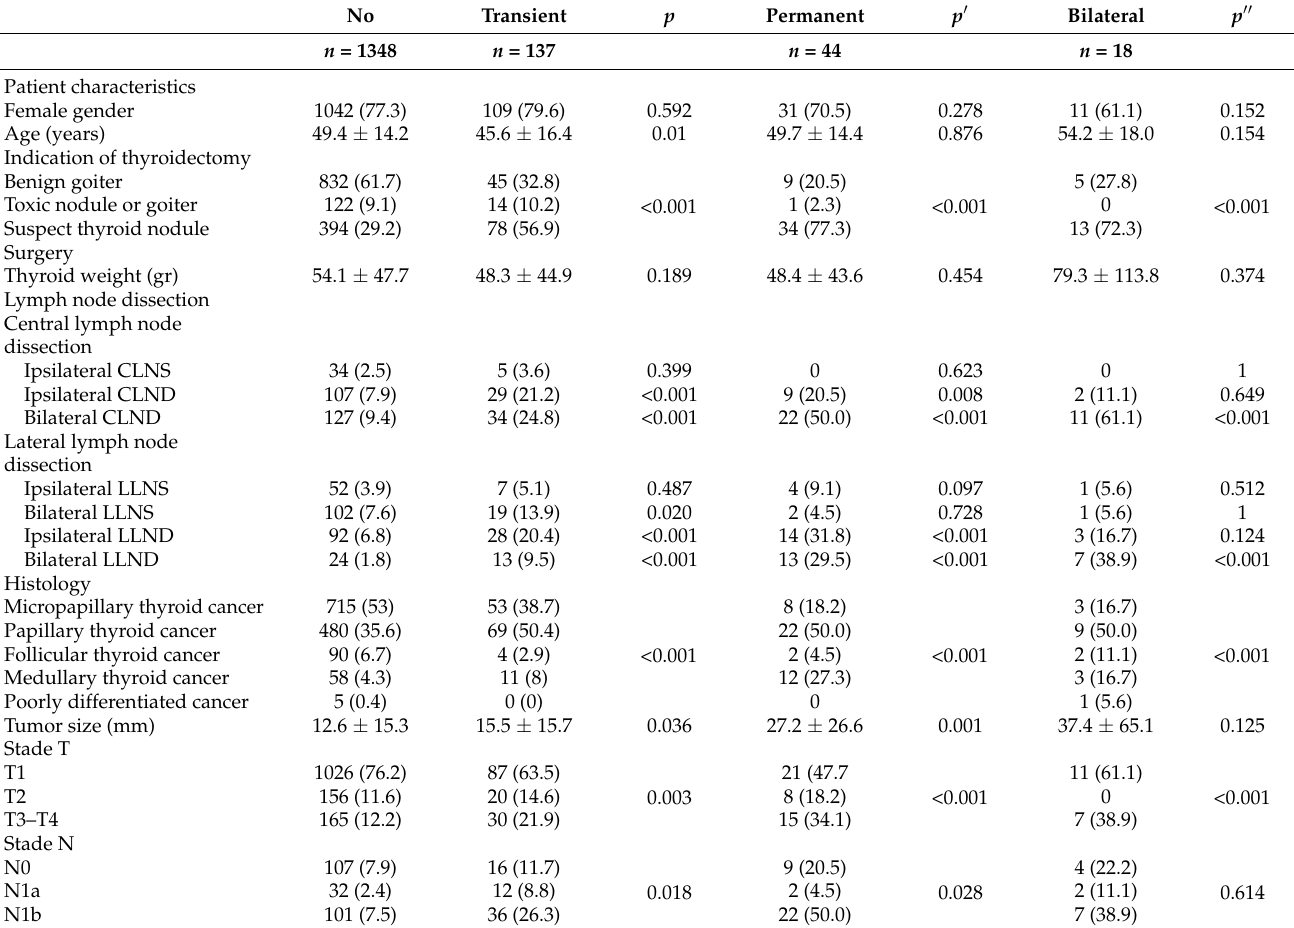
Table 5. Univariate analysis of predictive factors associated with transient, permanent of bilateral RLN